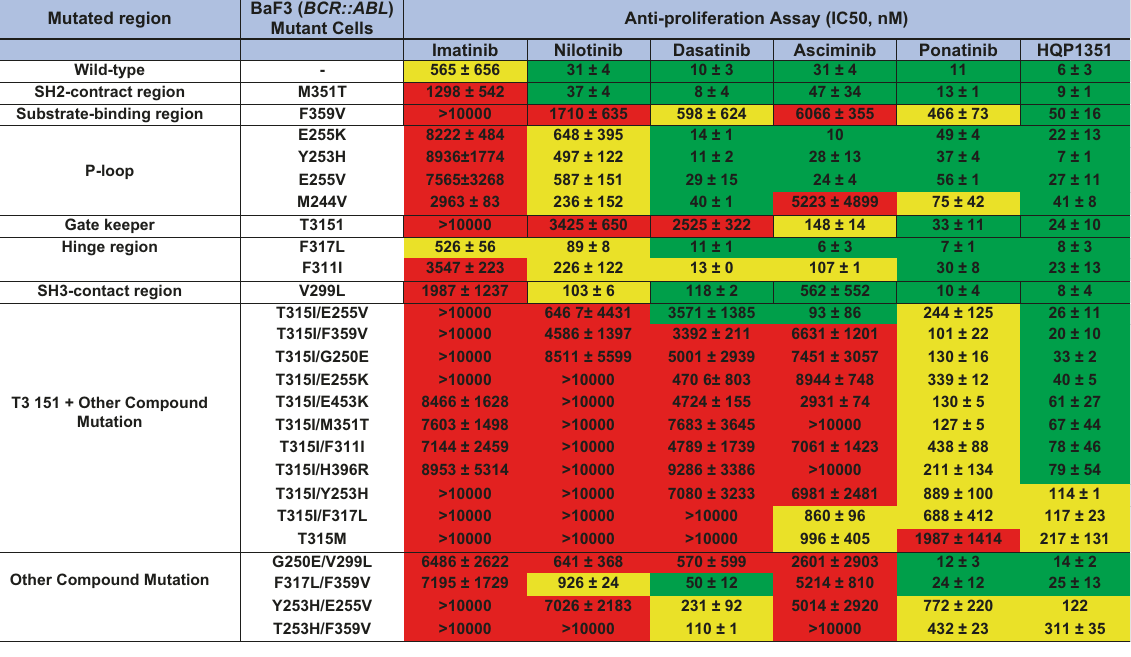
Table 2. The spectrum of TKI sensitivity according to the different ABL1 kinase domain mutations, including compound mutations in Ba/F3 cells. BaF3 ( BCR::ABL ) Mutated region Mutant